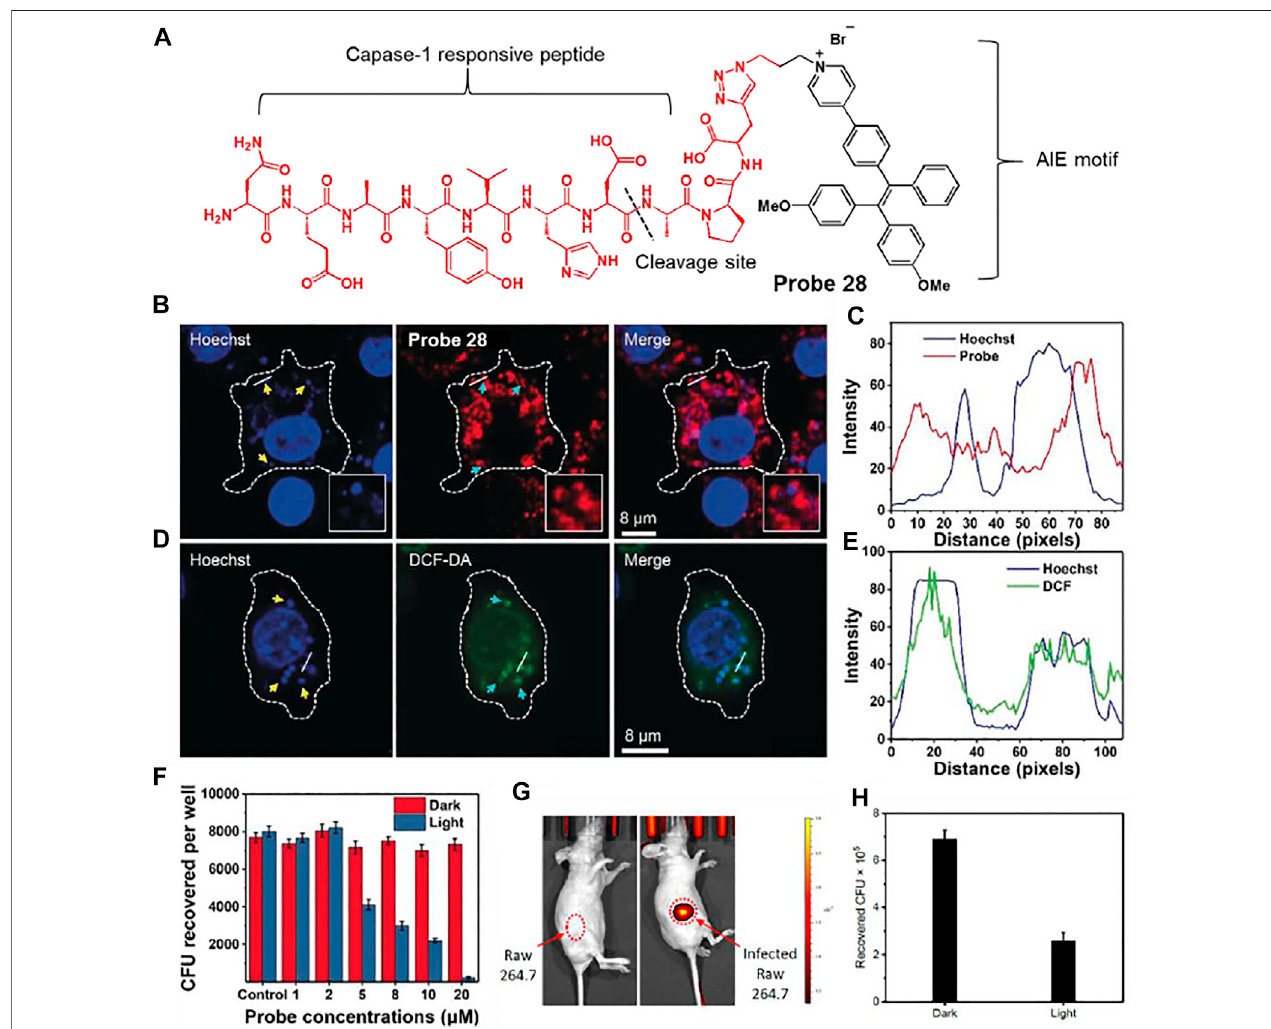
FIGURE 15 | (A) Chemical structure of probe 28. (B) Confocal microscopy images showing the localization of probe 28 after 60 min incubation in Raw 264.7 macrophages infected with S. aureus . (C) Fluorescence pro fi les of probe 28 (red) and bacterial DNA staining Hoechst dye (blue) across the phagosomes containing S. aureus (from the white straight lines in the confocal images). (D) Confocal microscopy images of ROS inside the macrophages using DCF-DA after bacterial infection in thepresenceofprobe28. (E) Fluorescencepro fi lesofDCF-DA(green)andbacterialDNAstainingHoechstdye(blue)acrossthephagosomescontaining S.aureus (fromthewhitestraightlinesintheconfocalimages).Yellowarrowsindicated S.aureus ,whilecyanarrowsdidphagosomescontaining S.aureus . (F) Intracellularsurvival of S. aureus in the Raw 264.7 macrophages at different concentrations of probe 28 without and with light irradiation for 10 min at 40 mW cm − 2 . (G) In vivo fl uorescence imagesofintracellularbacteria-bearingmiceafteri.v.injectionofprobe28. (H) CFUof S.aureus monitoredfromtheinfectedregionssubjectedtodarkorlightirradiation. Reproduced with permission from Qi et al. (2019). Copyright © 2019, Wiley-VCH Verlag GmbH & Co. KGaA, Weinheim.